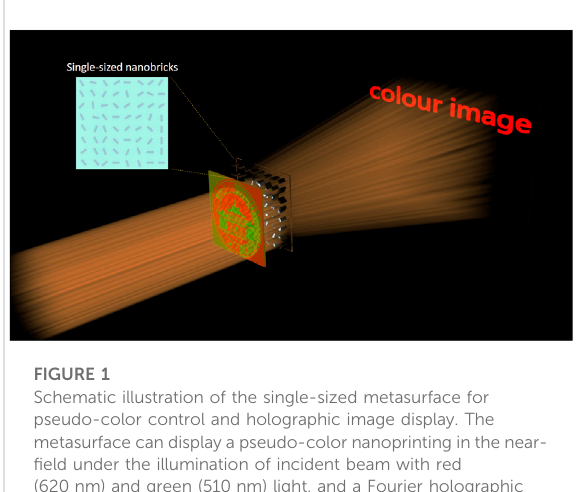
FIGURE 1 Schematic illustration of the single-sized metasurface for pseudo-color control and holographic image display. The metasurface can display a pseudo-color nanoprinting in the near- fi eld under the illumination of incident beam with red (620 nm) and green (510 nm) light, and a Fourier holographic image in the far- fi eld when the wavelength of incident beam is 620 or 510